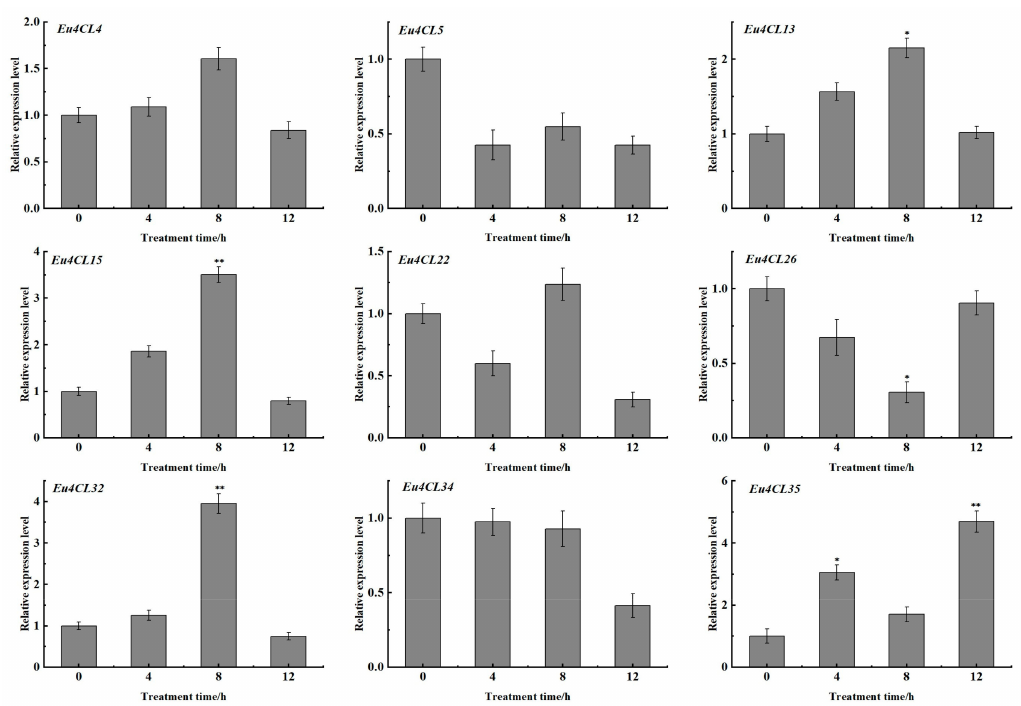
Figure 7. Expression profiles of selected Eu4CL genes under cold stress conditions. Error bars show the standard deviation of three biological replicates. * means significant correlation at a level of 0.05. ** means significant correlation at a level of 0.01.